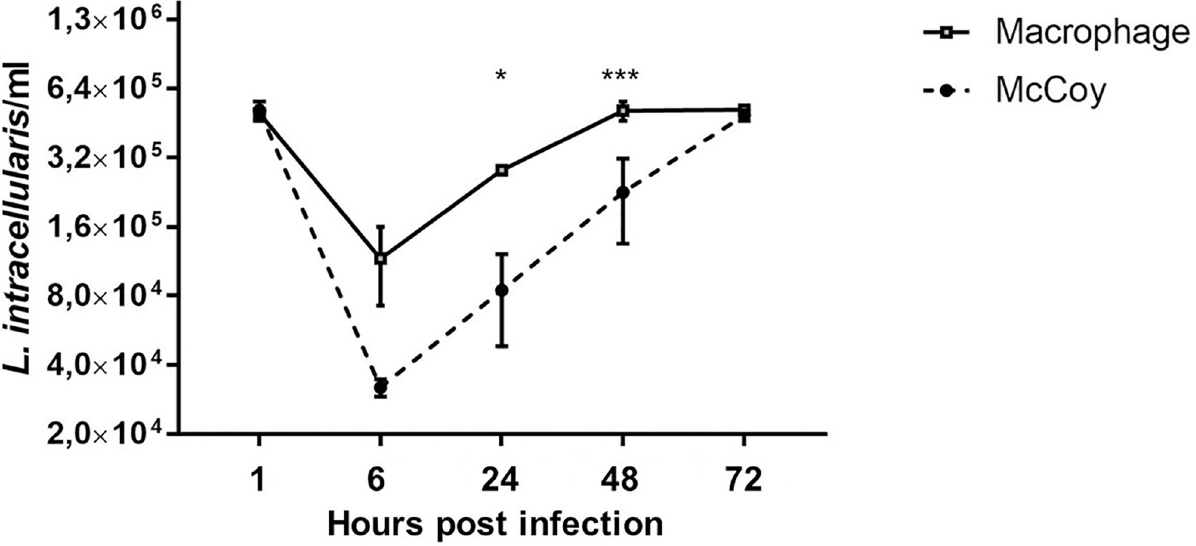
Fig 5. Quantification of Lawsonia intracellularis by qPCR. Time course of L . intracellularis mean quantification in macrophages and McCoy cells at 1, 6, 24, 48, and 72 hours post infection ± standard deviation of the mean. � P < 0 . 05 ; ��� P < 0 . 001 .